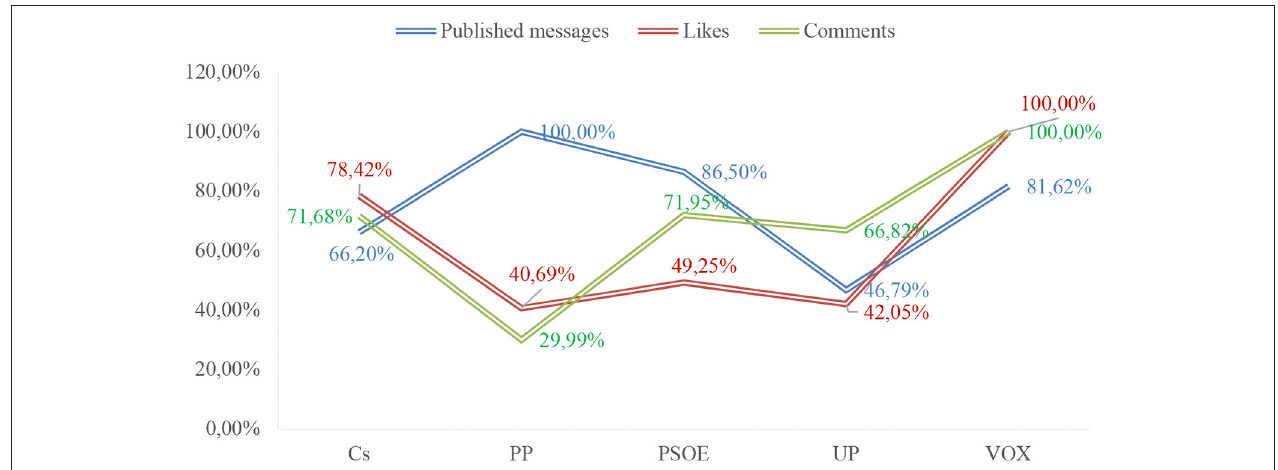
FIGURE 2 | General communication profiles of political parties during the General Elections (2015-2019). Source: Own elaboration. Retrieved from https://www. facebook.com/.